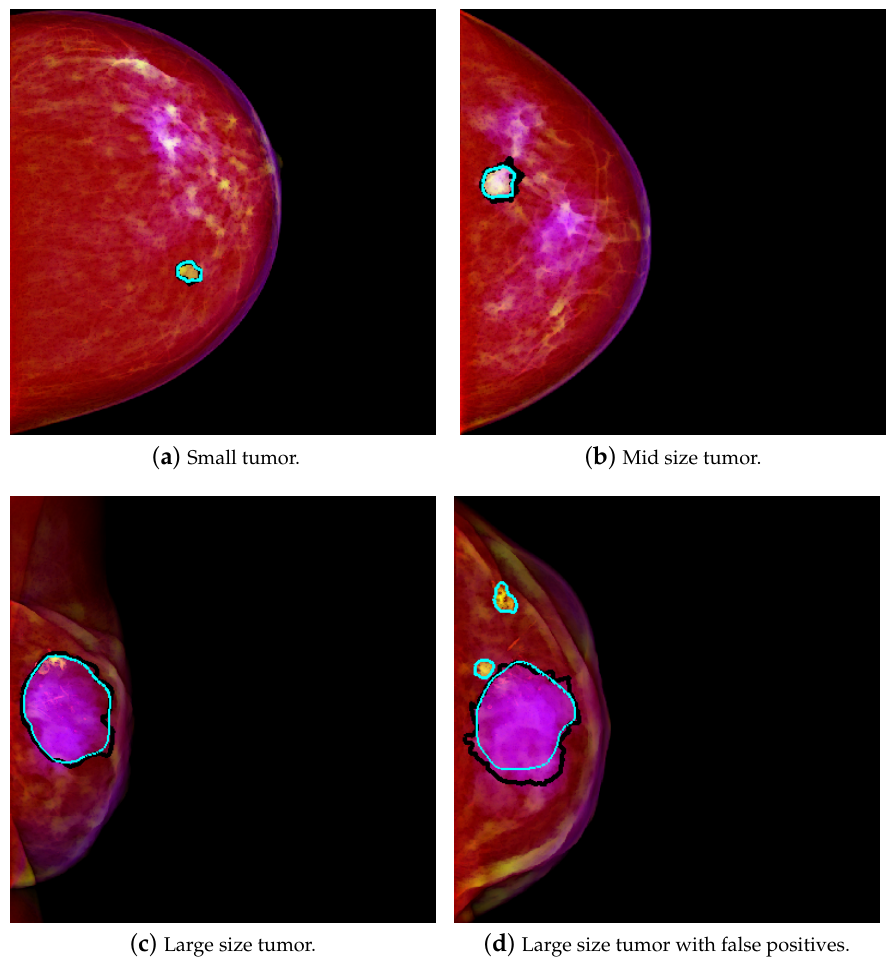
Figure 1. Some visual results of automatic detection and segmentation of breast masses. Black and cyan lines respectively stand for ground truth of the masses and segmentation of the detected